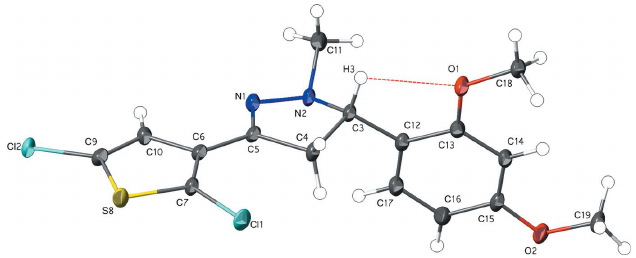
Table 2 Experimental details. Crystal data Chemical formula